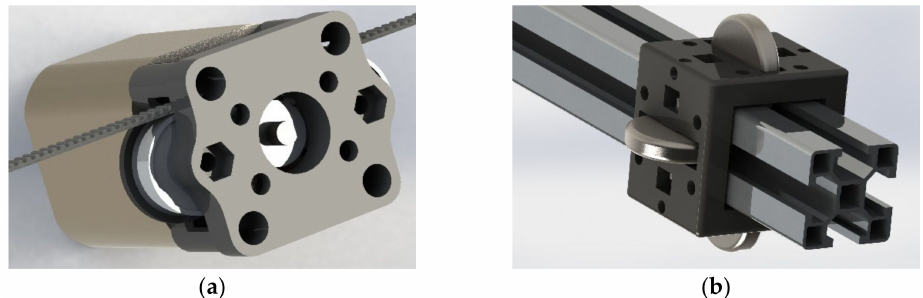
Figure 2. CAD models of components used to construct the three-axis linear robot. ( a ) 3D printed component attached to the face of each stepper motor uses deep groove ball bearings to wrap a timing belt around a timing pulley, coupled with the motor. ( b ) 3D printed linear bearing with fixed axial rotation, steel wheels, and M4 boltholes for integrating components.